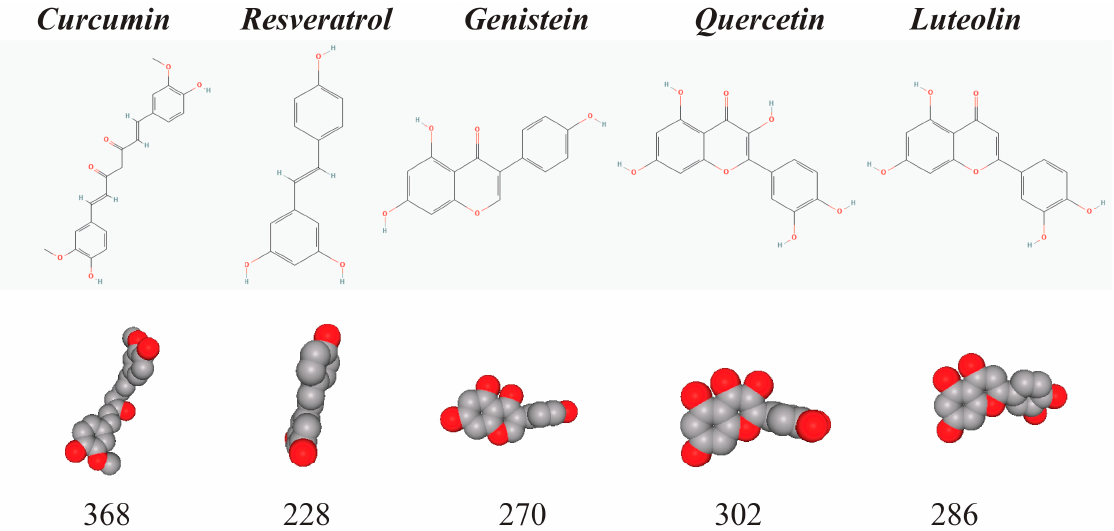
Figure 1. Chemical structures of curcumin, resveratrol, genistein, quercetin, and luteolin. This figure shows chemical structures (top row), space-filling models (medium row), and exact mass (bottom row) of curcumin, resveratrol, genistein, quercetin, and luteolin. Curcumin is a diarylheptanoid from the group of curcuminoids, while resveratrol is a 3,4 ′ ,5-trihydroxy-trans-stilbene. Genistein, quercetin, and luteolin are flavonoids derived from a 15-carbon skeleton with two aromatic phenyl rings (A and B). Flavonoids also contain a heterocyclic pyran ring (C) with an embedded oxygen. These are small molecules—with molecular weight between 228 and 368—that are aromatic. For example, curcumin and resveratrol contain two aromatic phenyl rings. Note that such natural phenols are chemically active in many types of organic reactions that are common in a living cell, such as free radical chemistry, nucleophilic addition, or metal ion interactions [8].